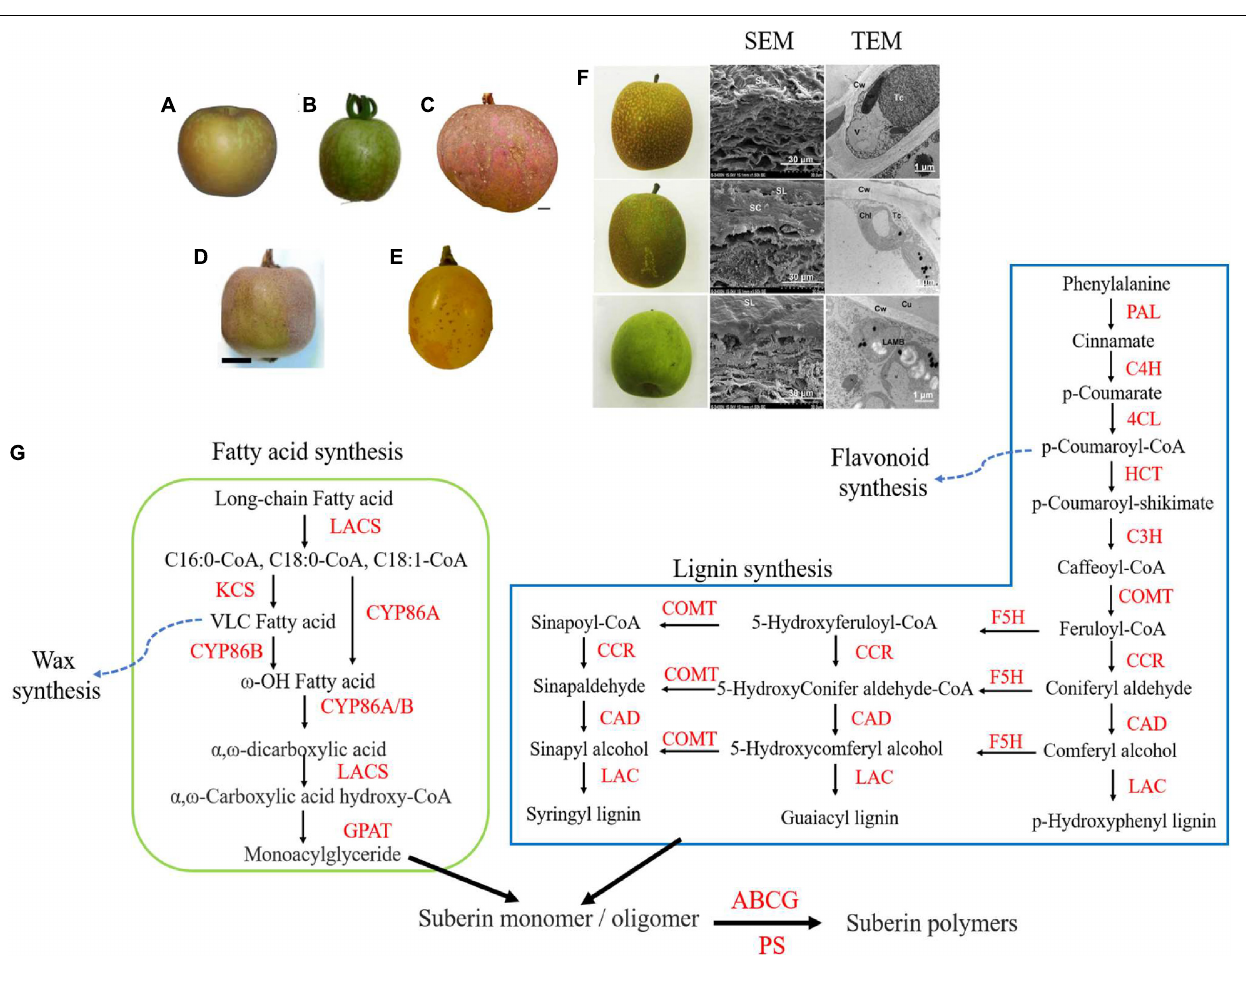
FIGURE 1 | The russet symptoms of different fruits and the proposed model of russeting in tree fruit. (A–E) The russet symptom of “Rugiada” apple, SlDCR-RNAi tomato, “Apple” mango, kiwifruit, and “Sunshine Muscat” grape (derived from Lashbrooke et al., 2016; Athoo et al., 2020; Huang et al., 2020; Falginella et al., 2021; Macnee et al., 2021, respectively). (F) The symptoms and microscopic histomorphology of “Zaoshengxinshui” (upper), “Cuiguan” (middle), and “Cuiyu” (lower, derived from Wang et al., 2021). (G) A proposed model of russeting in tree fruit. The lignin synthetic and fatty acid synthetic pathway provide precursors for